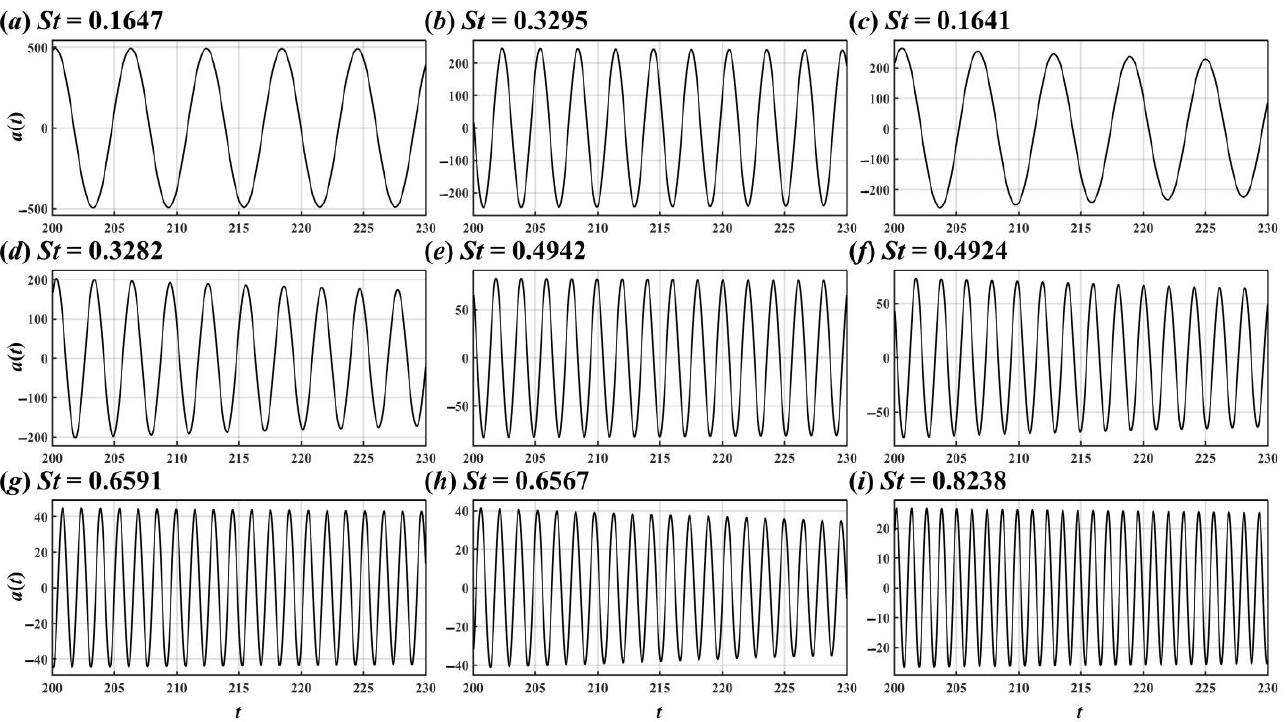
Figure 19. Time coefficients of the St = 0.1647 ( a ), 0.3295 ( b ), 0.1641 ( c ), 0.3282 ( d ), 0.4942 ( e ), 0.4924 ( f ), 0.6591 ( g ), 0.6567 ( h ), and 0.8238 ( i ) DMD modes for the flow around the single cylinder. Two DMD modes with close frequencies occurred in pairs around St = 0.165, 0.33, 0.49, and 0.66 (i.e., St = 0.1647 and 0.1641, 0.3295 and 0.3282, 0.4942 and 0.4924, and 0.6591